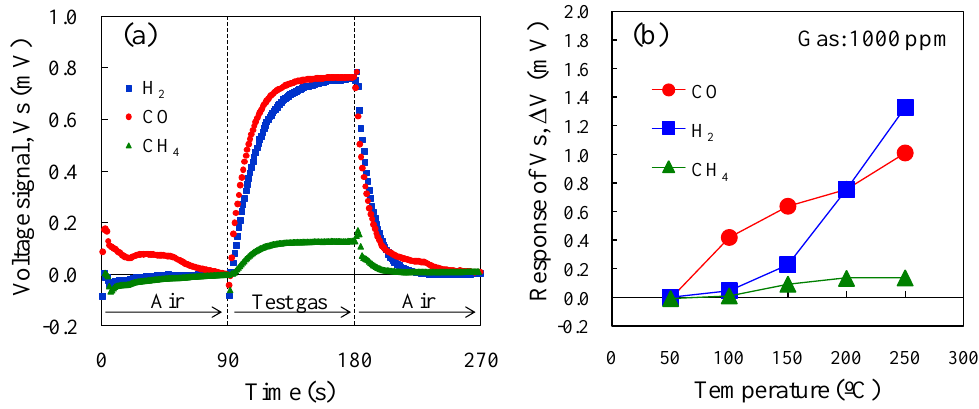
Figure 8. Vs of the AuPtPd/SnO 2 micro-TGS for 1000 ppm H 2 , CO, and CH 4 in dry air. ( a ) Response curves of the micro-TGS at a catalyst temperature of 200 °C, and ( b ) the ΔV of the micro-TGS at 25–300 °C.